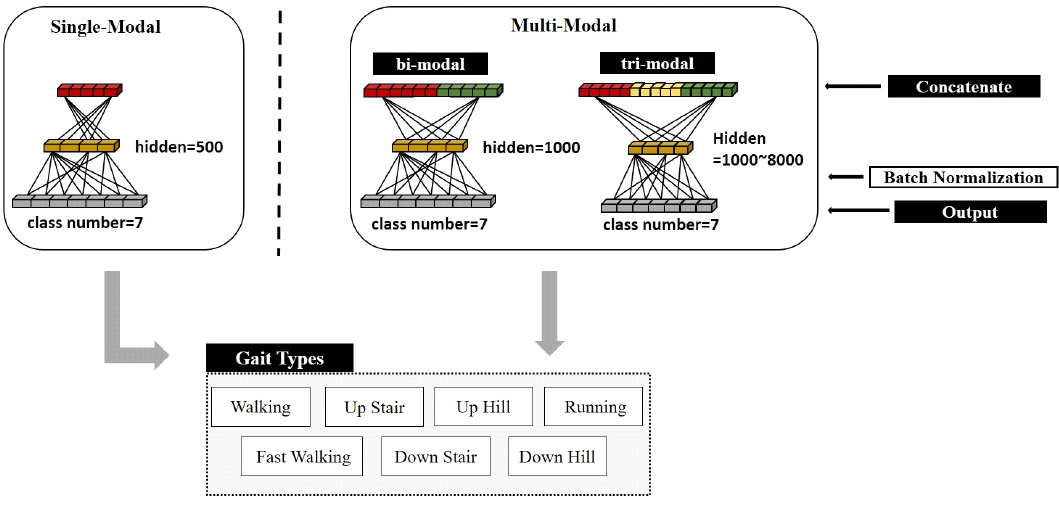
Figure 8. Structure of a fully connected network that determines the type of gait using the single- and multi-modal DCNN feature vector as